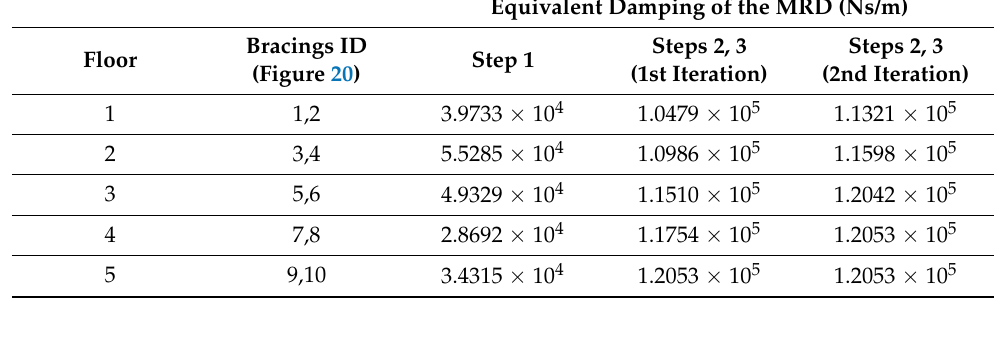
Table 4. Equivalent damping values for the MRD activated with a current of 0.5 A.